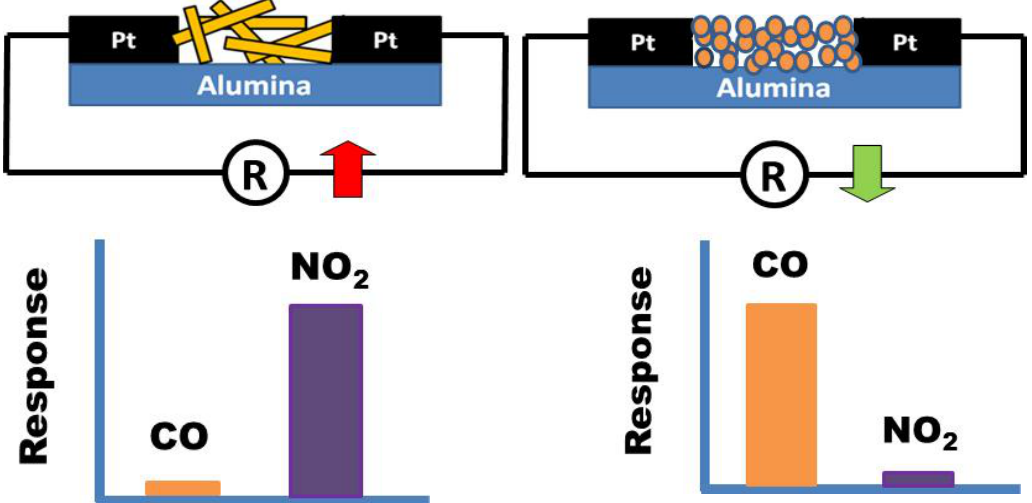
Figure 9. Schematic representation of the distribution of semiconducting particles on the substrate and related sensitivity